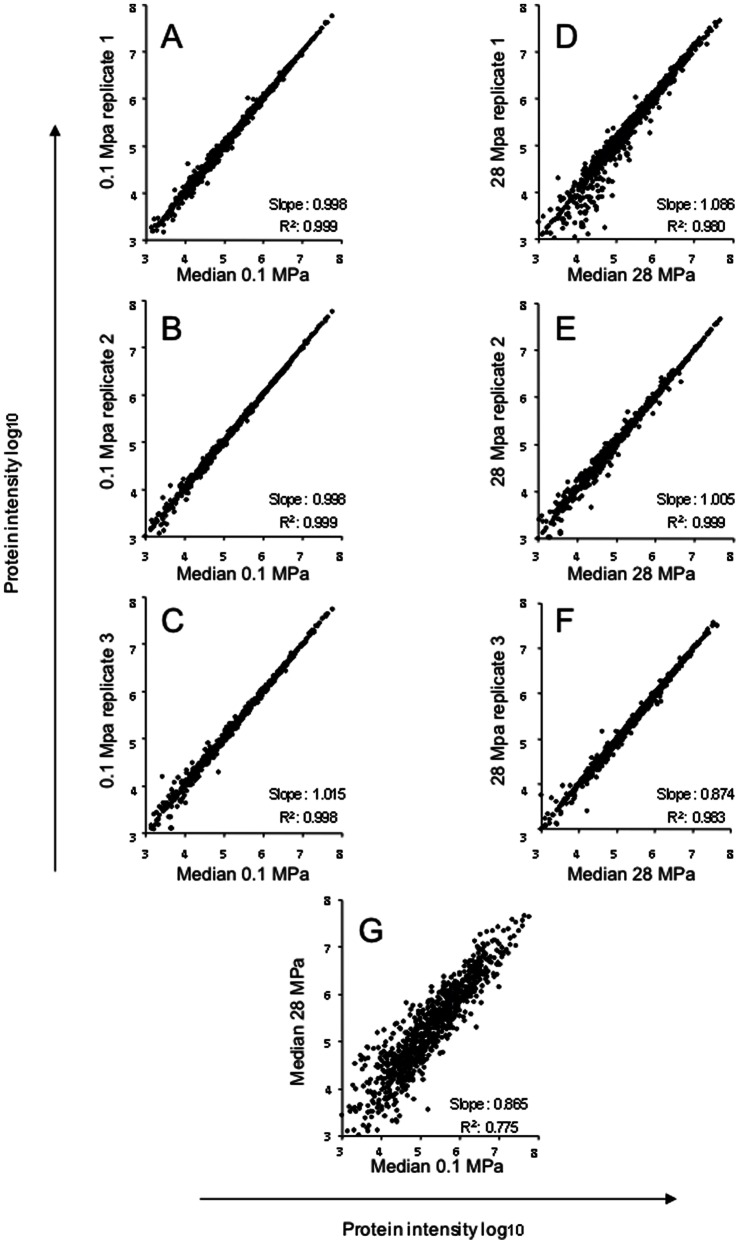
Scatter plot of the non-transformed protein intensity plotted against their median intensity group.In Fig. 2A, B, C, the biological triplicates grown at 0.1 MPa (replicates 1 to 3) is plotted in against the 0.1 MPa median intensity group. In Fig. 2D, E and F, the biological triplicates grown at 28 MPa (replicate 1 to 3) is plotted against the 28 MPa median group. In Fig. 2G, the median intensity at 28 MPa is plotted against the median intensity at 0.1 MPa. Slope and regression coefficients are also highlighted in each plot. The non- transformed protein intensity was extracted using Progenesis (see material and methods section for details).